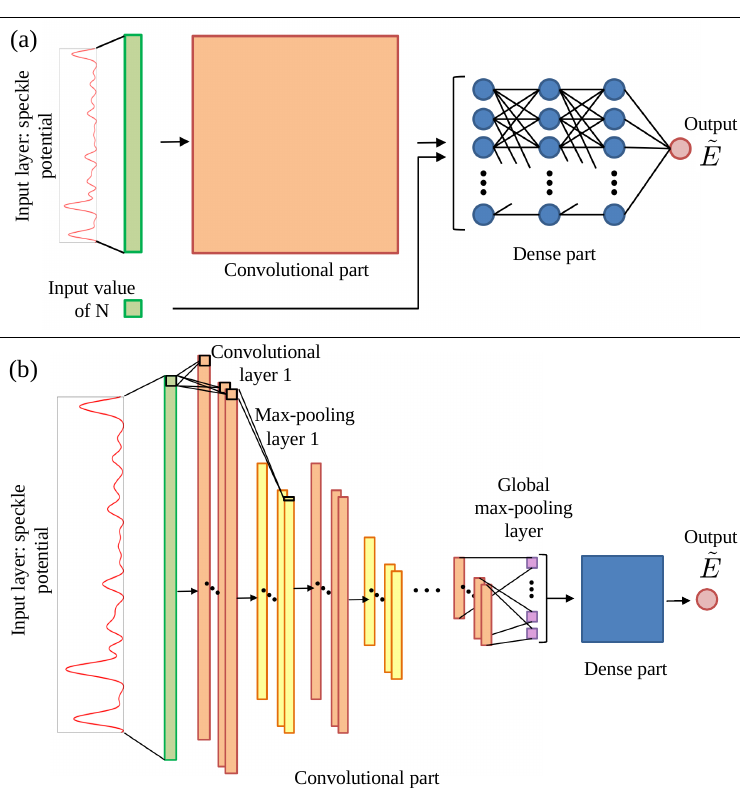
Figure 1: (a) Schematic representation of the deep feed-forward neural network used to predict the ground-state energy, ˜ E , of few-boson systems (output). The input descriptors are the values of the speckle potential on a fine discrete grid. In the case of training with heterogeneous datasets, an additional system descriptor is included, representing the particle number N . This descriptor is connected directly to the dense part of the network. (b) Structure of the convolutional part of the neural network. This model is used when training on homogeneous datasets including instances with a unique particle